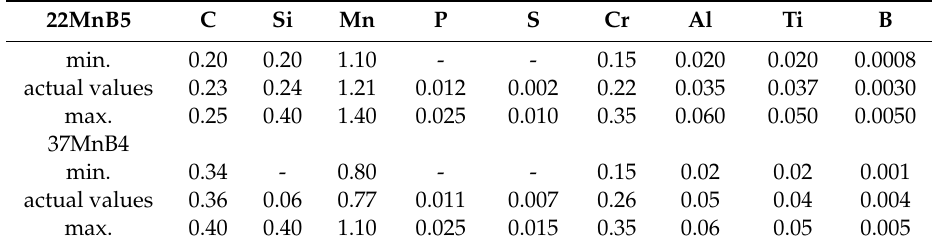
Table 2. Measured chemical composition in % by weight of 22MnB5 and 37MnB4, min / max values taken from [20].